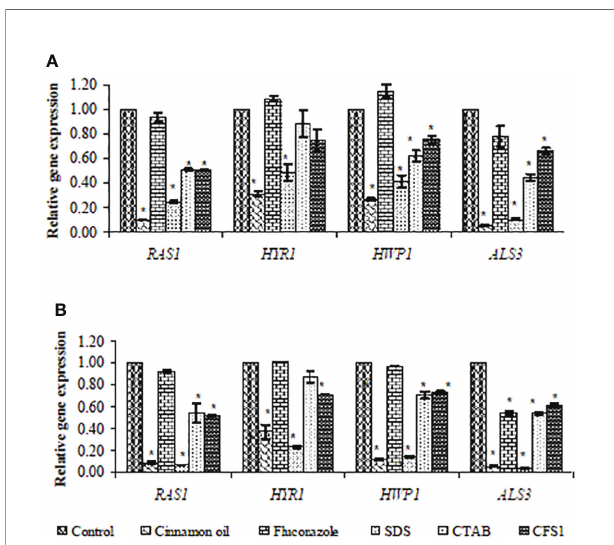
FIGURE 2 | Fold change in expression of hypha-speci fi c genes ( HYR1 , HWP1 , and ALS3 ) and the hyphal regulator RAS1 in strong bio fi lm producers C. albicans isolates (code nos. 20 (A) and 26 (B) , Table 2 ) after treatment with the sessile minimal inhibitory concentration (SMIC50) of cinnamon (1, 4 µg/ml), fl uconazole (1,024 µg/ml), SDS (0.62%), CTAB (1.25, 0.62%), and CFS1 (1, 2 µg/ml), respectively. The results were the average of three